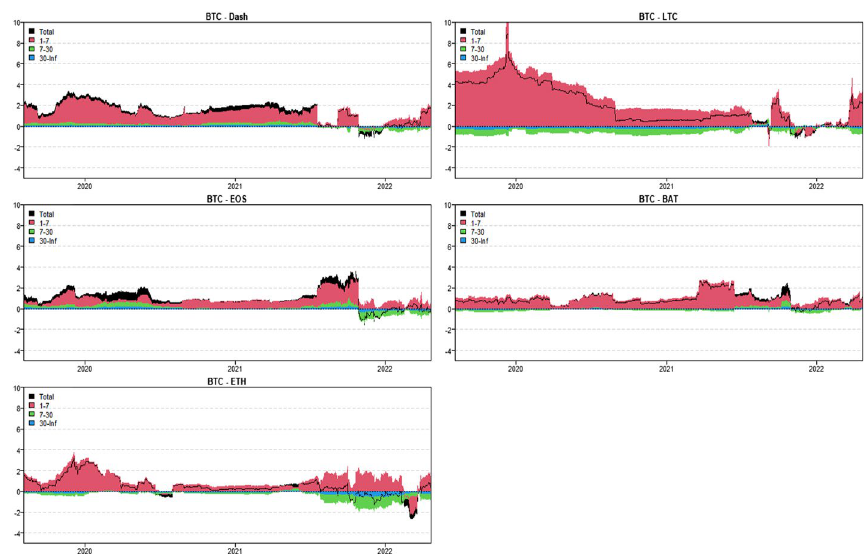
Fig. 15 Dynamic net-pairwise connectedness—realized skewness